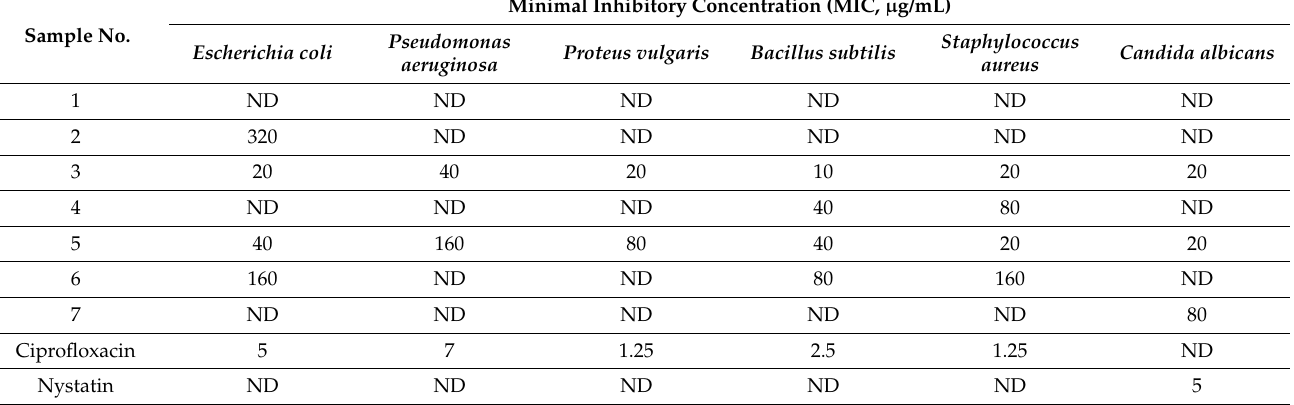
Table 1. Antimicrobial activity and minimal inhibitory concentration (MIC) of synthesized thiadiazole